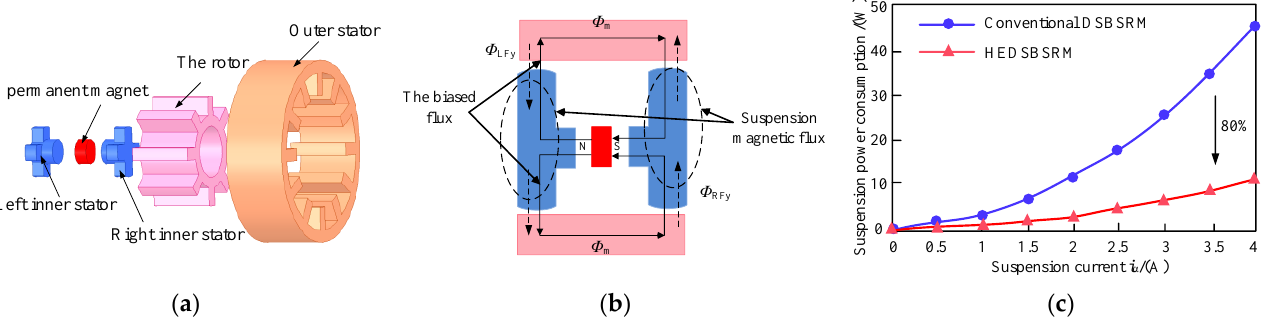
Figure 9. Axially magnetized double stator BSRM: ( a ) Motor topology diagram; ( b ) Biased magnetic circuit and control flux path; and ( c ) Suspension power consumption.